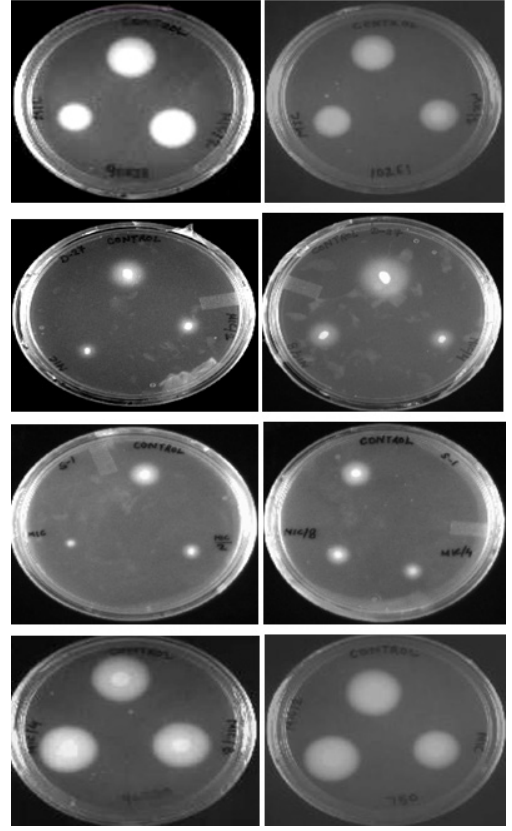
Fig. 4. (a) BSA agar plates showing the proteinase secretion in C. albicans ATCC 90028 and 10261 (A, B), C. albicans D-27 (C, D), C. albicans S-1 (E, F), C. glabrata ATCC 90030 (G), C. tropicalis ATCC 750 (H), in the presence of geraniol at 1/8 MIC, 1/4MIC, ½ MIC and